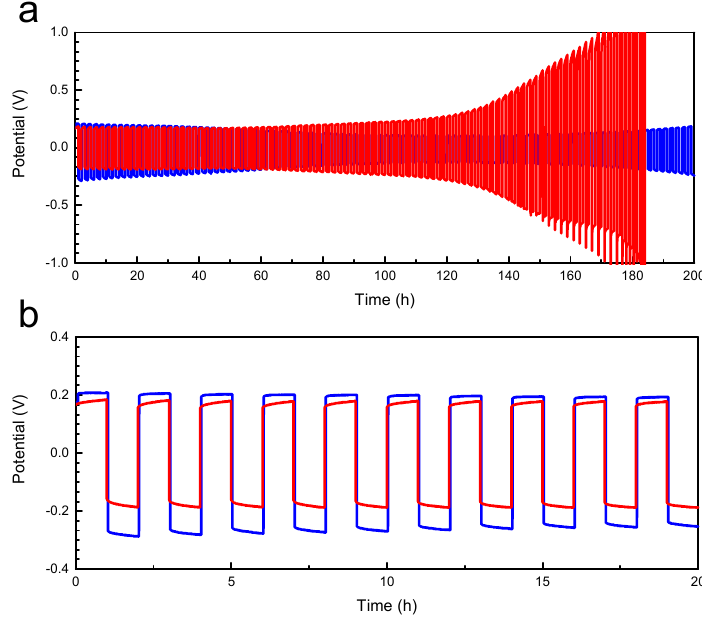
Figure 7. Galvanostatic cycling of SPE-3 DP29. ( a ) Data of a best (blue) and worst (red) performing cell show stable cycling up to 60 and > 100 cycles (120 h and > 200 h, respectively) before a significant overpotential develops. ( b ) Similar initial voltage response over the hour half cycles, with flat overpotentials. The tests were performed at 70 ◦ C, and r = 0.08, in a symmetrical Li / SPE / Li cell with 1 h forward current followed by 1 h reverse current at 0.02 mA cm − 2 .